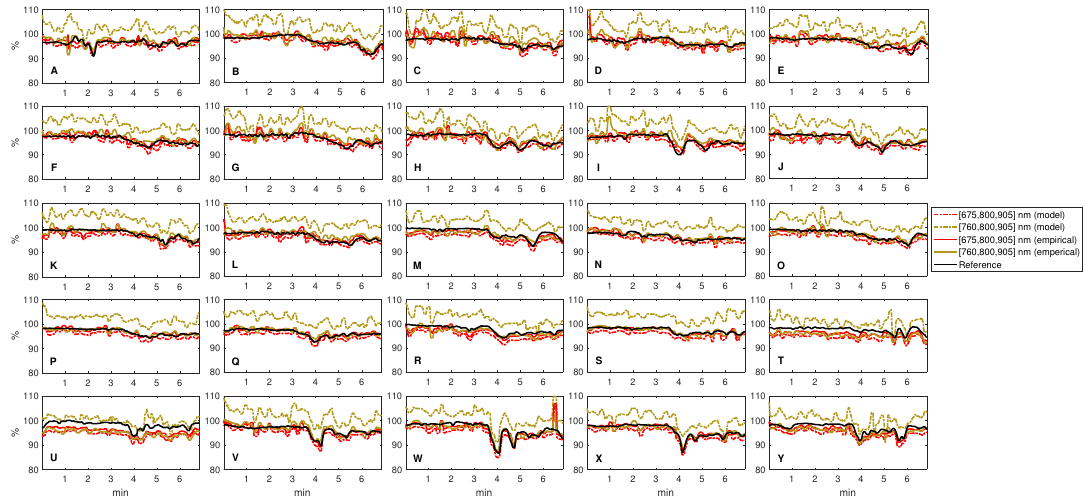
Figure 9. An overview of the SpO 2 traces from all the recordings in the dataset ( n = 25) shows the necessity of the proposed empirical calibration